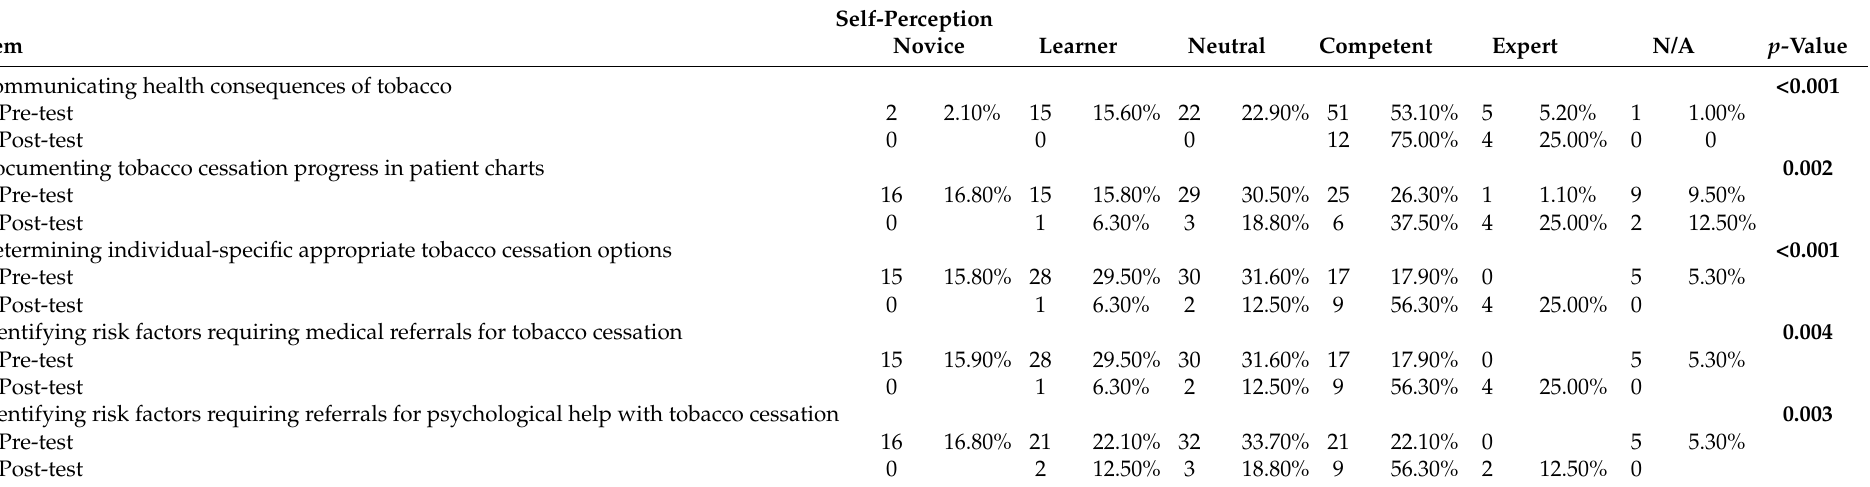
Table 3. Behavioral/outcome practices: Self-Perceived Level of Skill Comparison of Pre-test and Post-test.